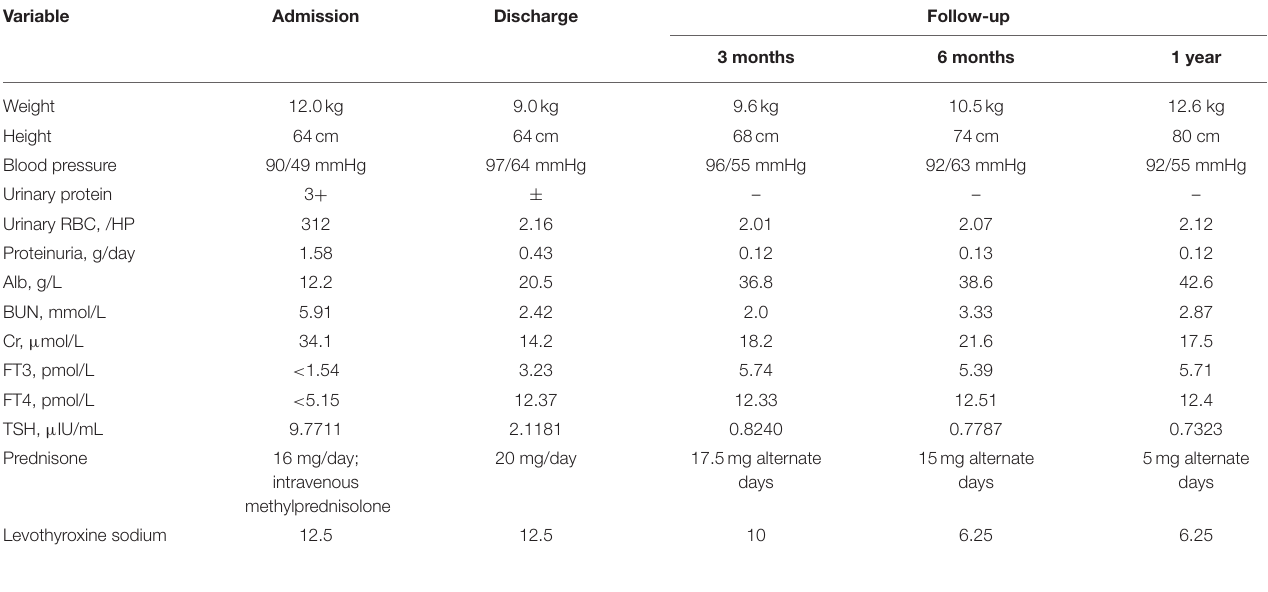
TABLE 2 | Changes of renal function parameters and other clinical parameters during the course of disease.